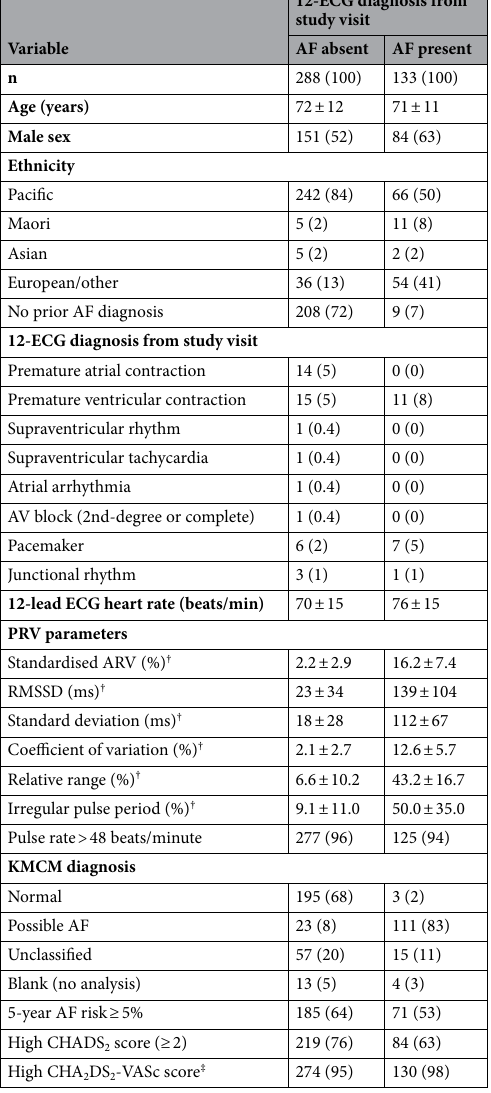
Table 1. Characteristics of participants. AF atrial fibrillation, AV atrioventricular, KMCM Kardia Mobile Cardiac Monitor, PRV pulse rate variability, RMSSD root mean square of successive differences. *Values are n (column %) or mean ± standard deviation, unless otherwise indicated; † Median ± interquartile range; ‡ CHA 2 DS 2 -VASc score ≥ 1 (males) or ≥ 2